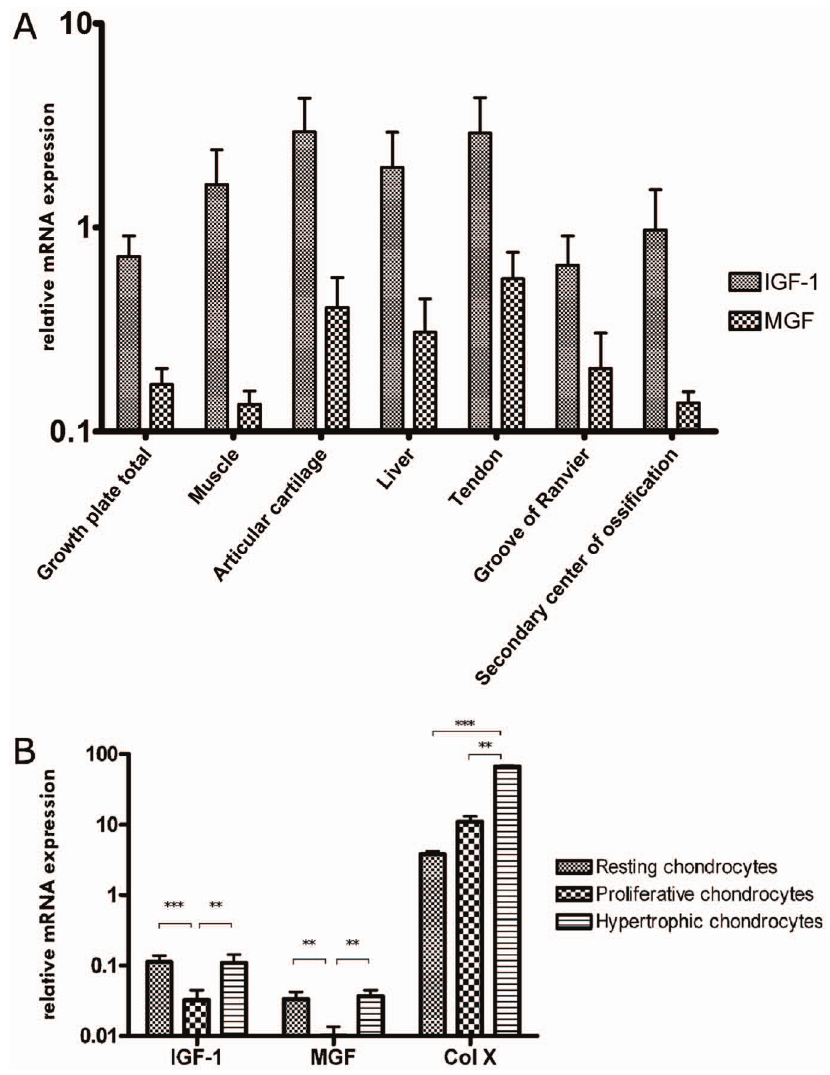
Figure 3. Mgf and Igf1 mRNA expression profile (normalized to 18S rRNA) of various porcine tissue samples (A) and within different zones of the growth plate separated by laser capture microdissection (B) as quantified by real-time PCR. (n $ 3 per tissue, One-way ANOVA of log-transformed data (a) or Kruskal-Wallis with Bonferroni-adjusted post-hoc tests (b) were used to detect differences between groups: ** p , 0.01; ***p , 0.001 vs proliferative chondrocytes; ### p , 0.001 vs hypertrophic chondrocytes. Data are presented as mean + SEM).